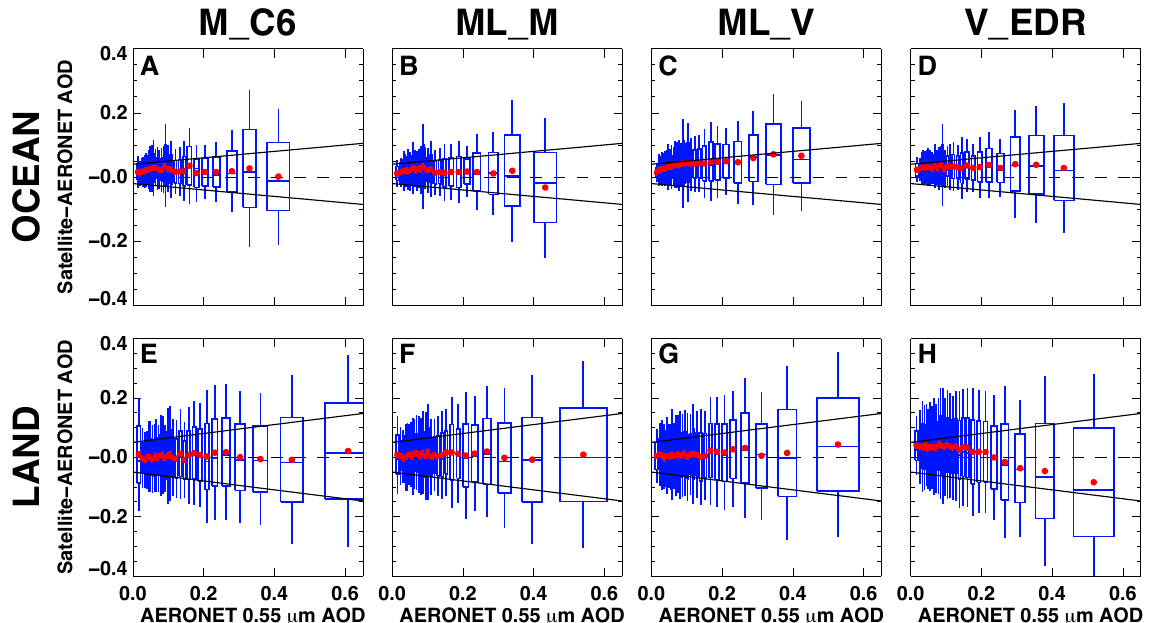
Figure 14. Global satellite-AERONET comparison of AOD at 0.55µm, for each of four satellite-derived data sets, for period March 2013– February 2014. For each panel, data are sorted by AERONET AOD, so that each box-whisker represents the same number of data points. The blue box and whiskers indicate the median 50%, the middle 66% and the middle 95% of the collocations. The red dots represent the mean for the set of collocations. The solid black lines indicate the expected error for MODIS as suggested by Levy et al. (2013), which is ± (0.05 + 15%) for land, and (0.04 + 10% and − 0.02–10%) over ocean. Details of the statistics, including linear regression statistics (satellite vs. AERONET) are listed as Table